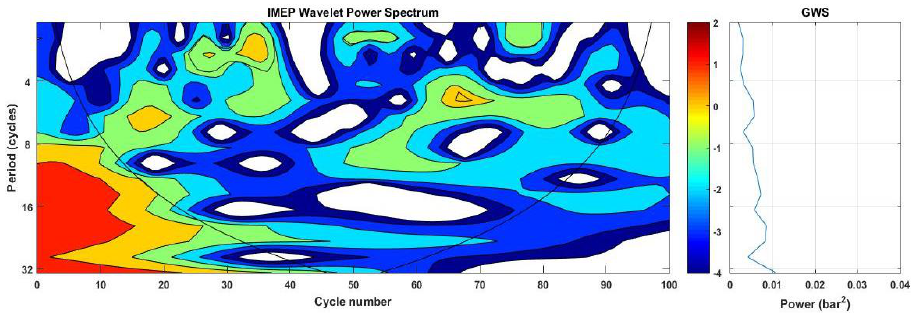
Figure 9. Wavelet analysis of IMEP (WPS and GWS), 20MPa_120BTDC_1050_Foul.